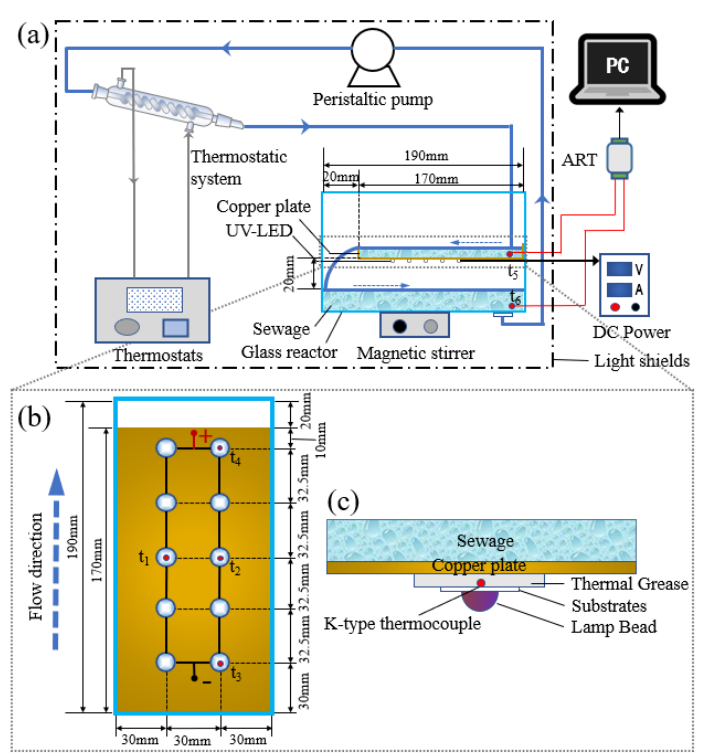
Figure 12. ( a ) Diagram of UV-LED/TiO 2 photocatalytic synergistic system. ( b ) UV-LED array layout diagram. ( c ) Vertical cross-section of lamp beads and copper plate.